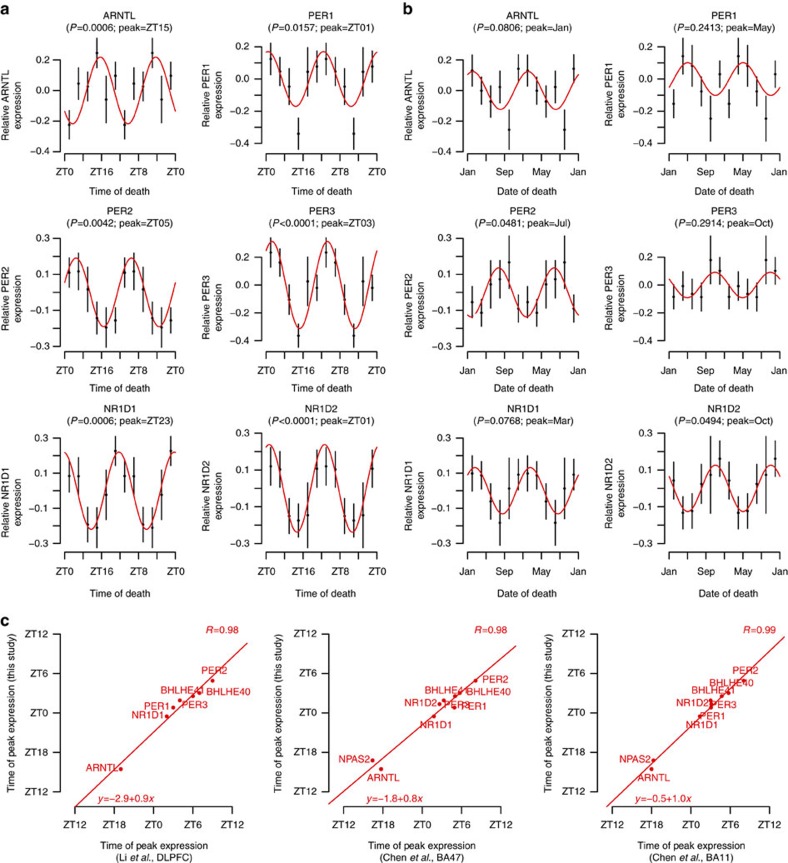
Diurnal and seasonal rhythms of clock gene expression.(a,b) Relative expression by (a) time of death and (b) month of death for several genes known to be involved in the regulation of the mammalian circadian clock. Data plotted in (a) 4-h or (b) 2-month bins. ZT0=sunrise. Dots indicate means and bars indicate s.e.'s of the mean. Data are double plotted. Red lines indicate fit cosine curve. P values for (a) diurnal or (b) seasonal rhythmicity are as calculated as described in the text using a model considering diurnal and seasonal rhythmicity concurrently, and adjusted for demographic and methodological covariates. (c) Correlation between the peak expression times of known circadian clock genes in our data set (y-axis) and published human prefrontal cortex data sets (x-axis). Red line indicates fit linear regression.